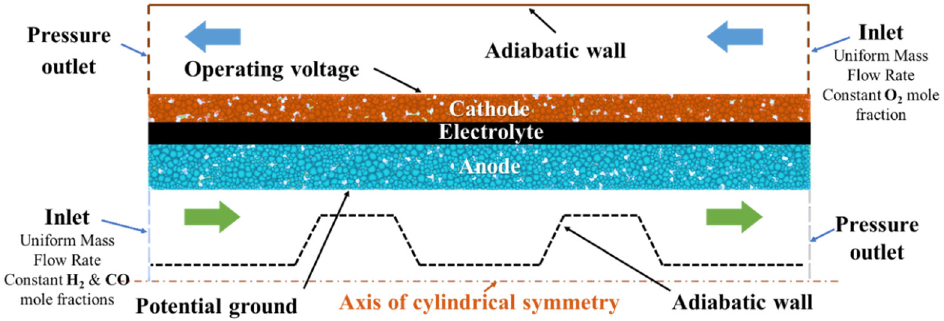
Figure 2. A summary of the simulation domain and boundary conditions of the tubular solid oxide fuel cells.